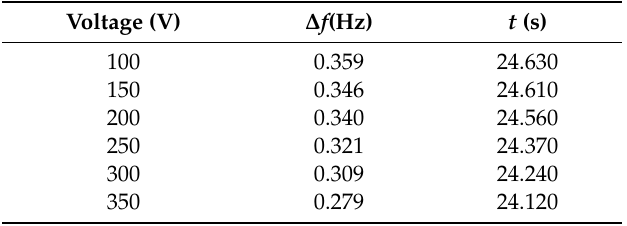
Figure 11. The theoretical estimations of frequency mismatch related ∆ f (cid:48) and the decay time related t (cid:48) of the resonator varying with the applied voltage or the distance between two electrodes: ( a ) The frequency mismatch related ∆ f (cid:48) varies with the applied voltage; ( b ) The decay time-related t (cid:48) varies with the applied voltage; ( c ) The frequency mismatch related ∆ f (cid:48) varies with the distance between two electrodes; ( d ) The decay time-related t (cid:48) varies with the distance between two electrodes. Table 6. The frequency mismatch related ∆ f and the decay time-related t in practice varying with the applied